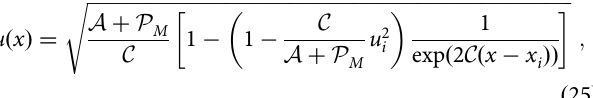
¼ 1 : 7988 ; E ¼ 0 : 4258 ; S ¼ 1 : 1941, M N M